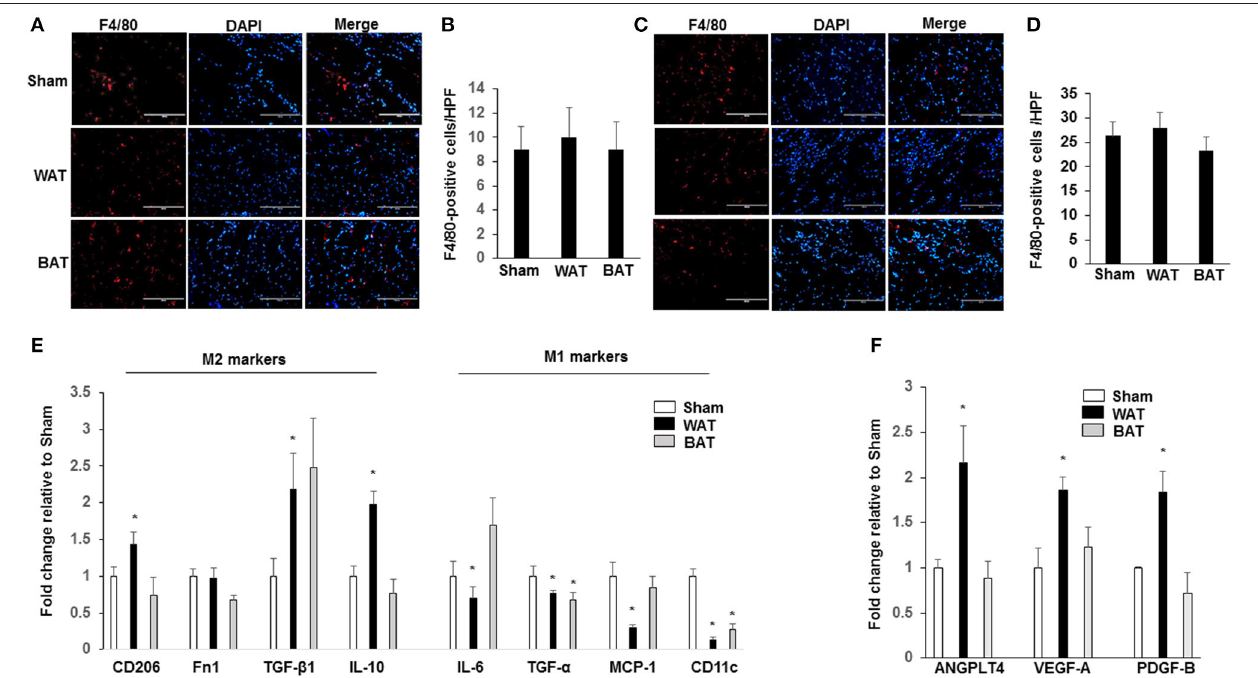
FIGURE 3 | Macrophages display an M2-phenotype in ischemic muscles from transplanted WAT mice. Representative images of macrophages as assessed by F4/80 immunostaining, in ischemic adductor muscle (A) and gastrocnemius muscle (C) recovered 21 days after femoral artery interruption. Quantification of anti-F4/80 positive-macrophage infiltration of ischemic adductor muscle (B) and gastrocnemius muscle (D) . Scale bars, 100 µ m. (E) . The gene profile of the M1- and M2-macrophage phenotype by quantitative RT-PCR of ischemic adductor muscles 21 days after surgery. (F) The gene analysis of ANGPTL4, VEGF-A, and PDGF-B by quantitative RT-PCR of ischemic adductor muscles 21 days after surgery. All bars show Mean ± SEM. Data are mean of triplicate experiments and are expressed as fold-control. * P < 0.05 toward sham-operated